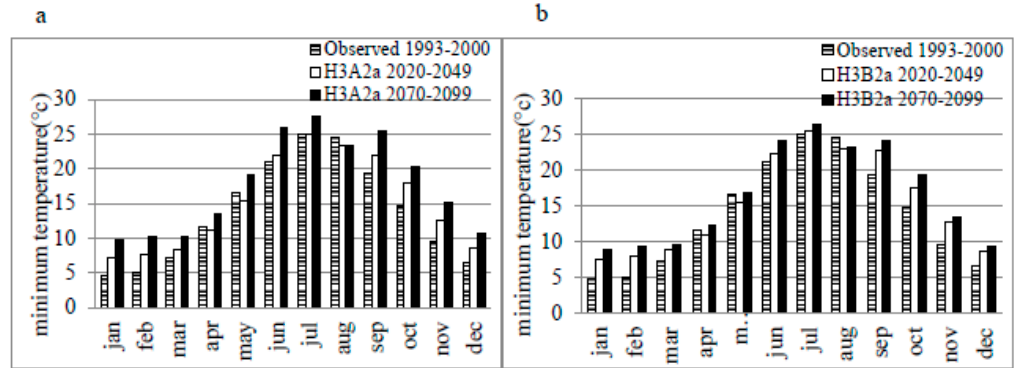
Figure 6. Values of monthly mean observed and predicted minimum temperature under ( a ) A2 and ( b ) B2 scenario in the near and far future.